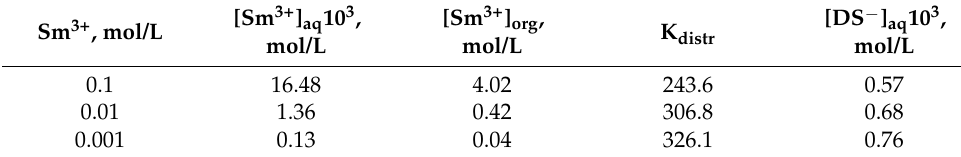
Table 5. Sm 3+ extraction with different initial concentrations at pH = 4.0.